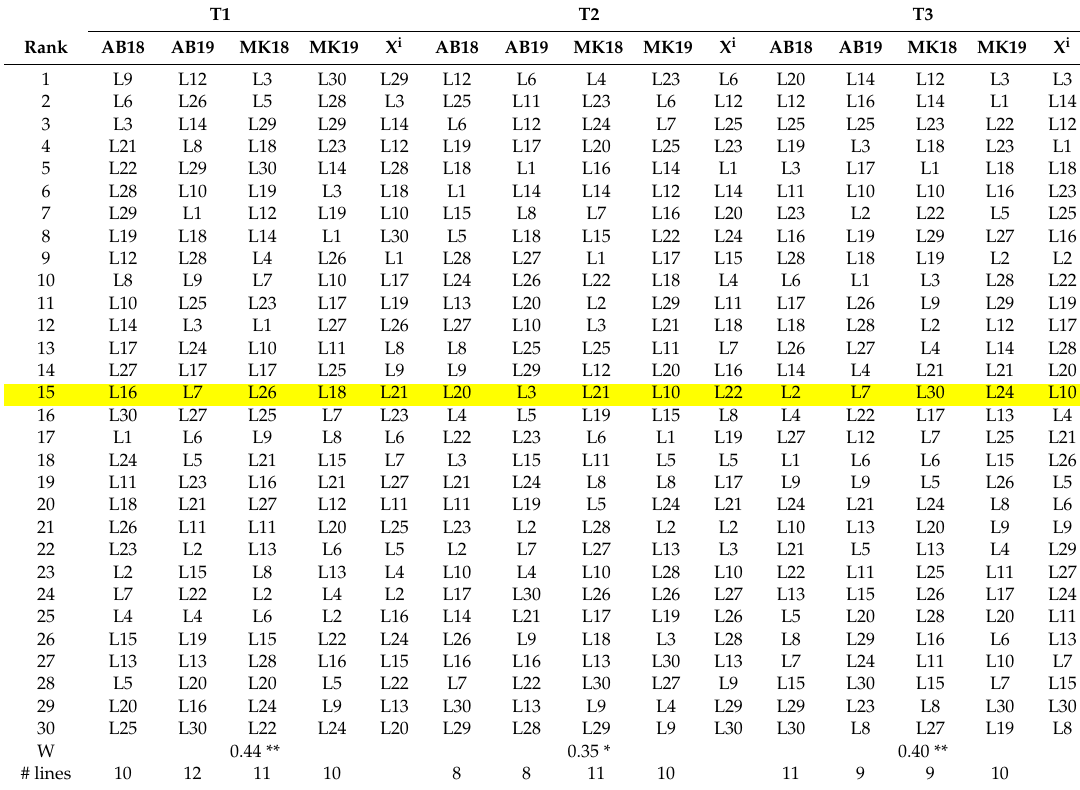
Table A6. Ranking Striga -resistant inbred lines based on average yield (kg / ha) performance across each environment in the combined analysis at Abuja and Mokwa, Nigeria for each tester under Striga infestation. T1